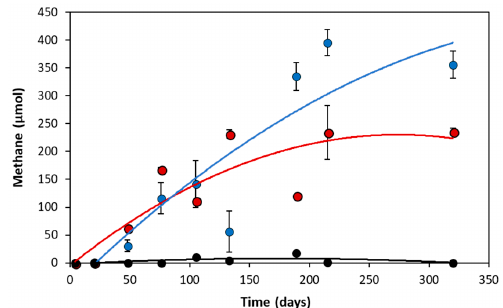
Figure 1. Methane production from transferred NDC incubations amended with naphthalene (blue) relative to substrate-unamended (red) and sterile (black) controls. Bars indicate ± average of duplicate microcosms.